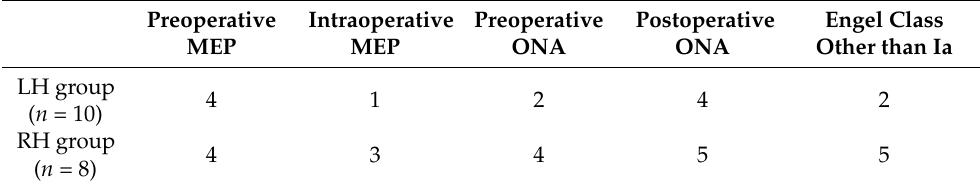
Table 2. Number of patients with affected clinical parameters in each patients’